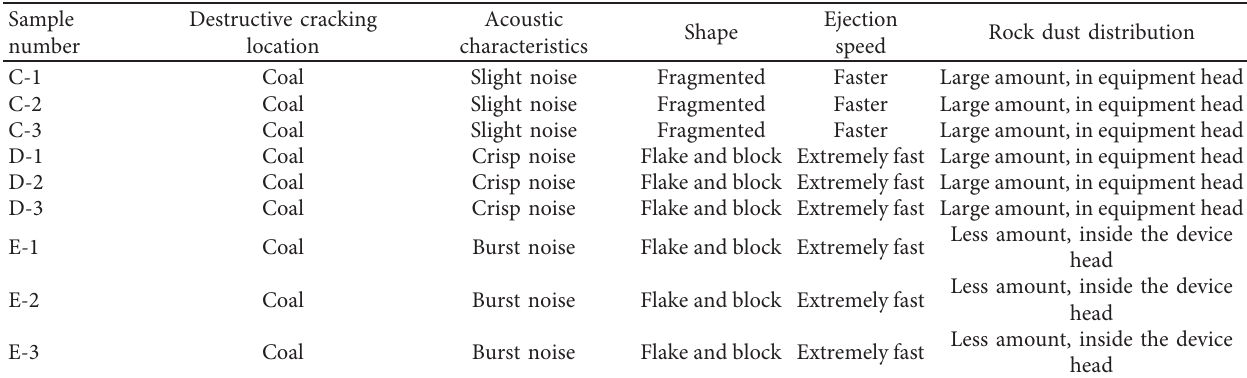
Table 3: Destruction characteristics of combined samples.